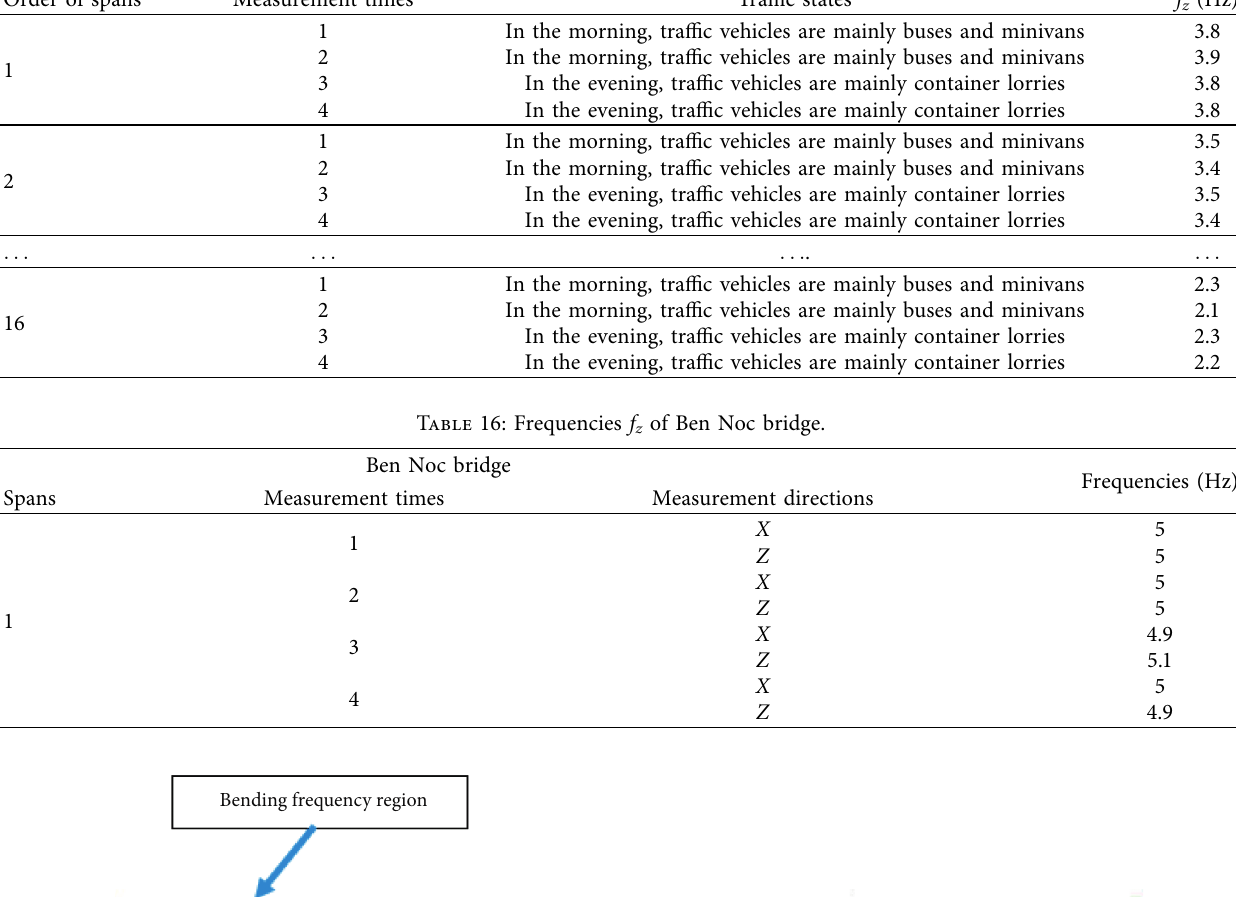
Table 15: Values f z at different spans of Sai Gon bridge.